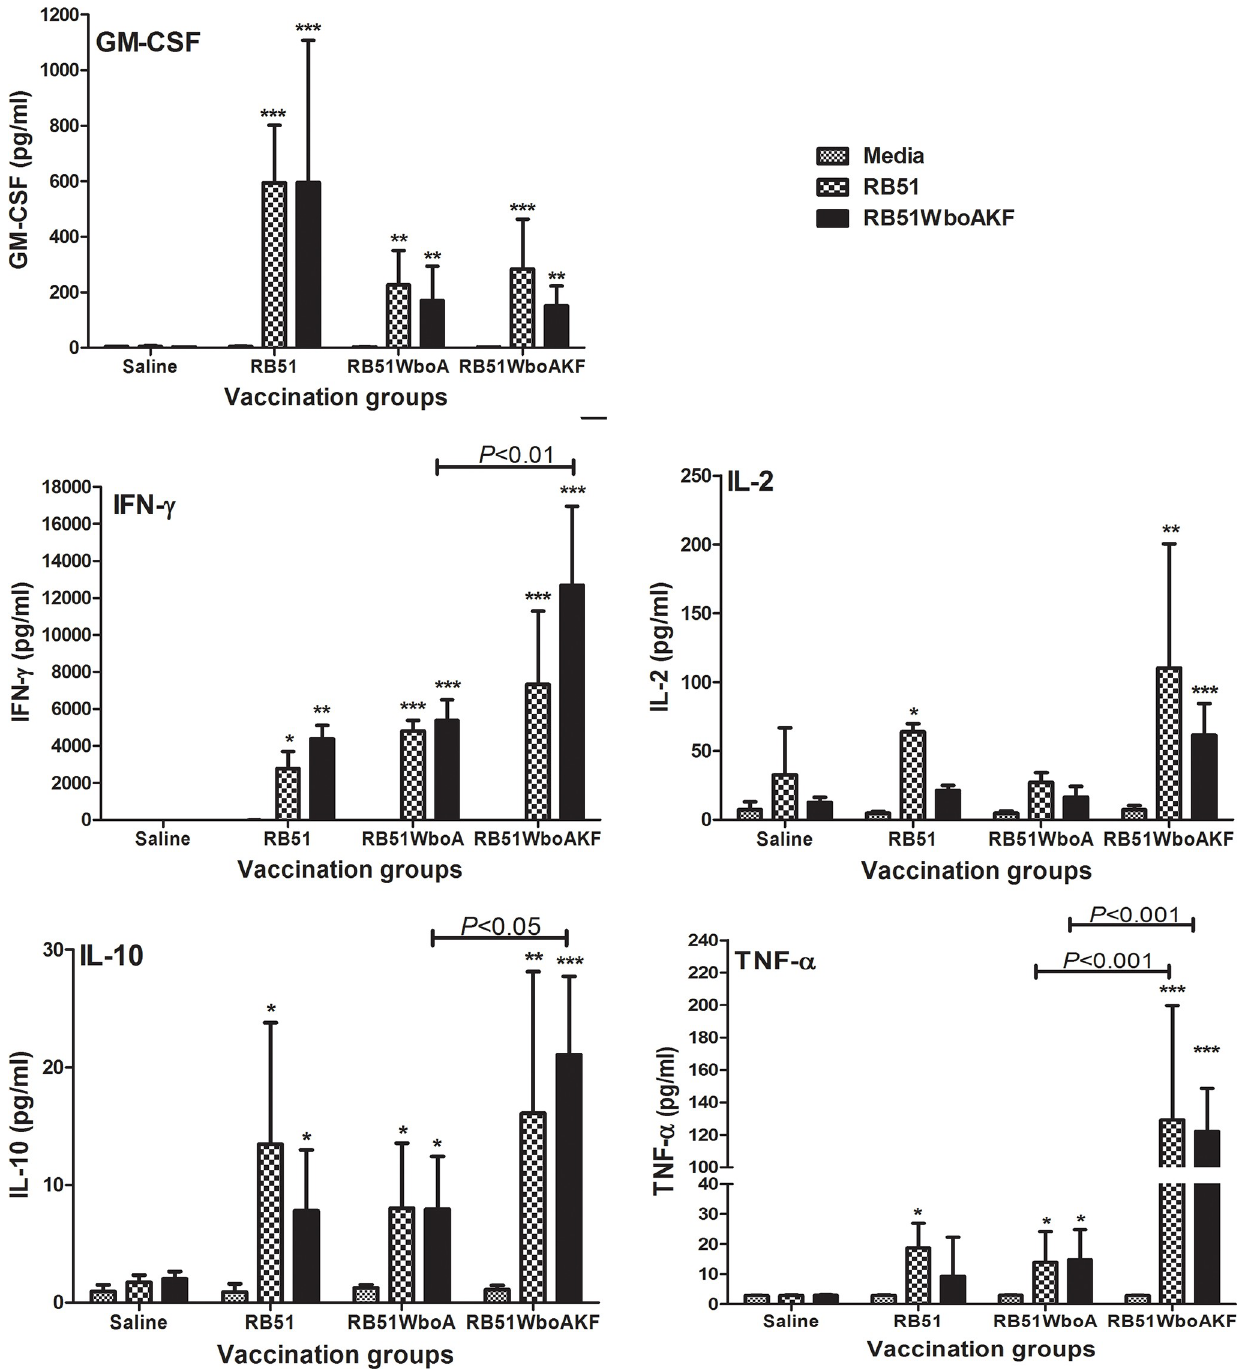
Fig 10. Detection of specific cytokines produced by splenocytes of vaccinated mice. Mice were vaccinated intra-peritoneally with 10 8 CFU of live RB51, RB51WboA, RB51WboAKF or inoculated with saline. Their splenocytes were harvested and stimulated in vitro with media (unstimulated), heat-killed RB51 or RB51WboAKF. Values are shown as mean ± standard deviation (n = 4). Asterisks indicate statistically significant differences from the corresponding unstimulated control. � , P < 0.05; �� , P < 0.01; ��� , P < 0.001.